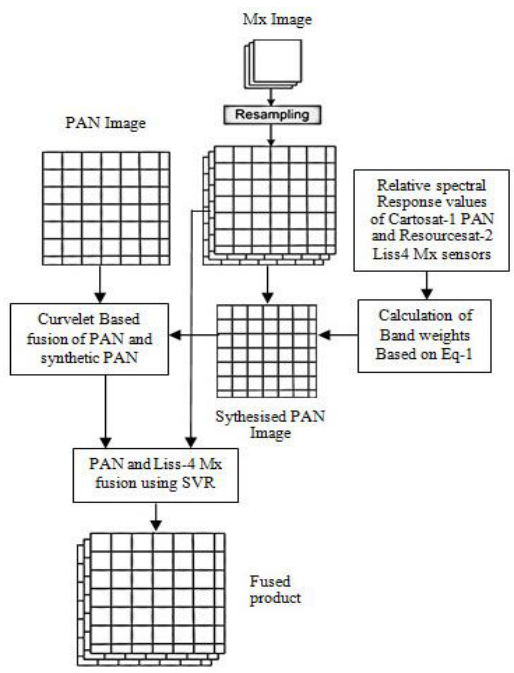
Figure 2: RSR and Curvelet based Optical Image Fusion As shown in the diagram, using relative spectral response values of the sensors, Cartosat-1 PAN and Resourcesat-2 Liss4 Mx, Equation- 1 is solved by multiple linear regression to obtain the band weights. The band weights are in turn used to synthesise PAN band using the Liss4 Mx multispectral bands. The obtained synthesised PAN band is highly correlated with the multispectral intensity image but lacks in spatial details from the original PAN image. The synthesised PAN band is sharpened with